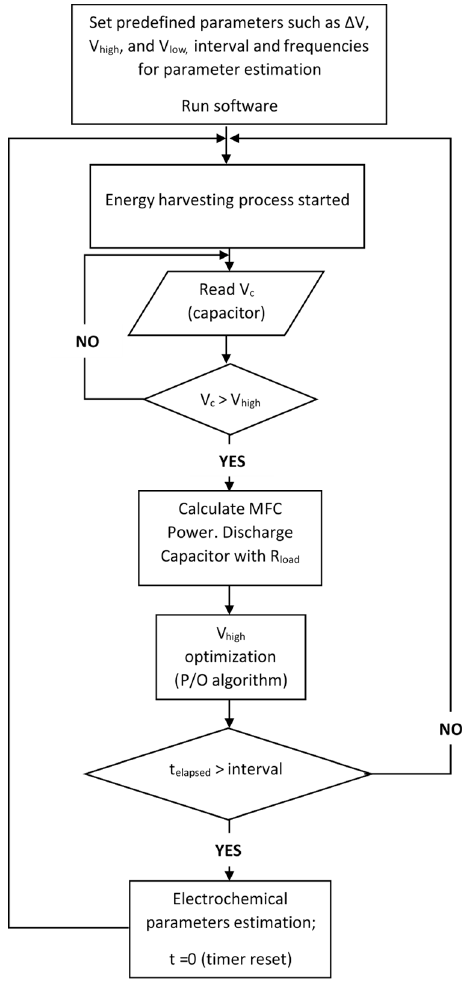
Figure 2. Flowchart of the power management algorithm of the biobattery.